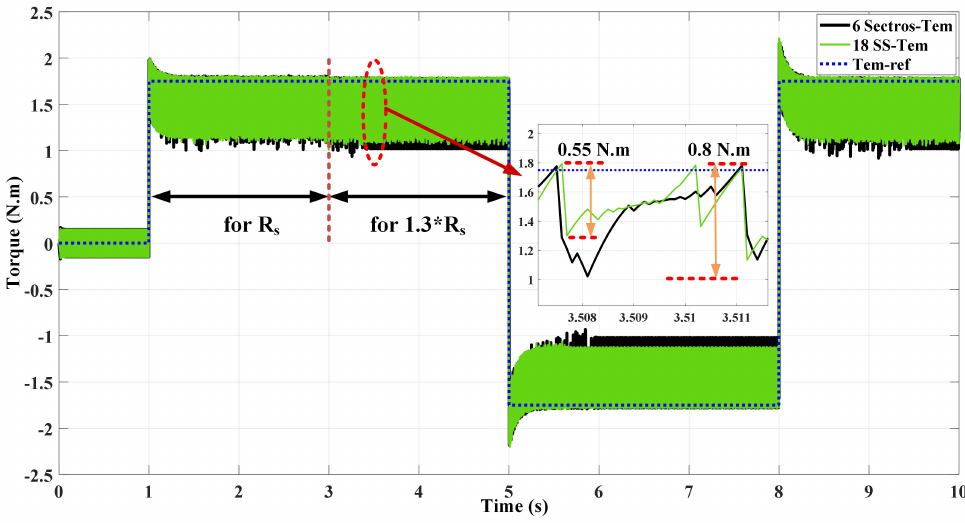
Figure 20. The torque signal of both the classical and improved strategies with Rs